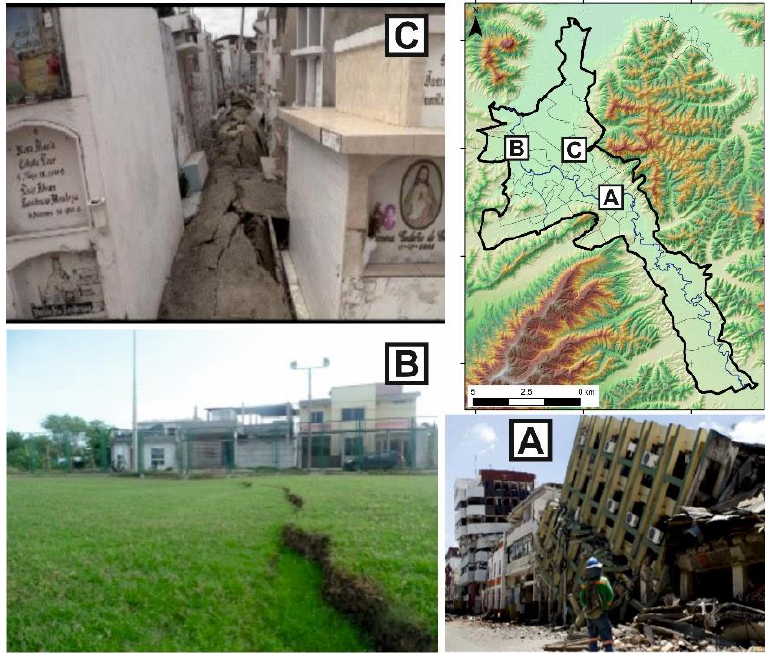
Figure 3. Representative examples of the liquefaction observed in the city of Portoviejo on 16 April 2016: ( A ); building damage from settlement and structural failure due to poor construction quality; ( B ) the presence of differential settlement in the soil of June 5 avenue; ( C ) settlement in the vaults in the general